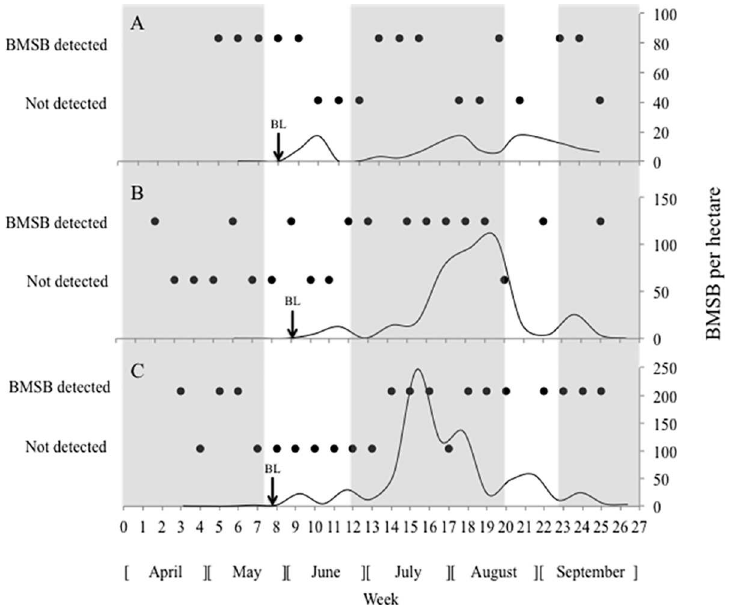
Fig 2. Weekly big brown bat ( Eptesicus fuscus ) guano samples from (A) Longmeadow Farm, (B) Strawberry Hill Farm, and (C) WM Schober Sons testing positive and negative for brown marmorated stink bug ( Halyomorpha halys ; BMSB). The secondary axis depicts seasonalBMSB density at each site. Shadedareas indicate BMSB springemergencefrom hibernation(Weeks 4–8), peak summer adult activity (Weeks 12–20), and fall aggregation at hibernationsites (Weeks 23–27). Arrows indicateweeks of first BMSB detectionin